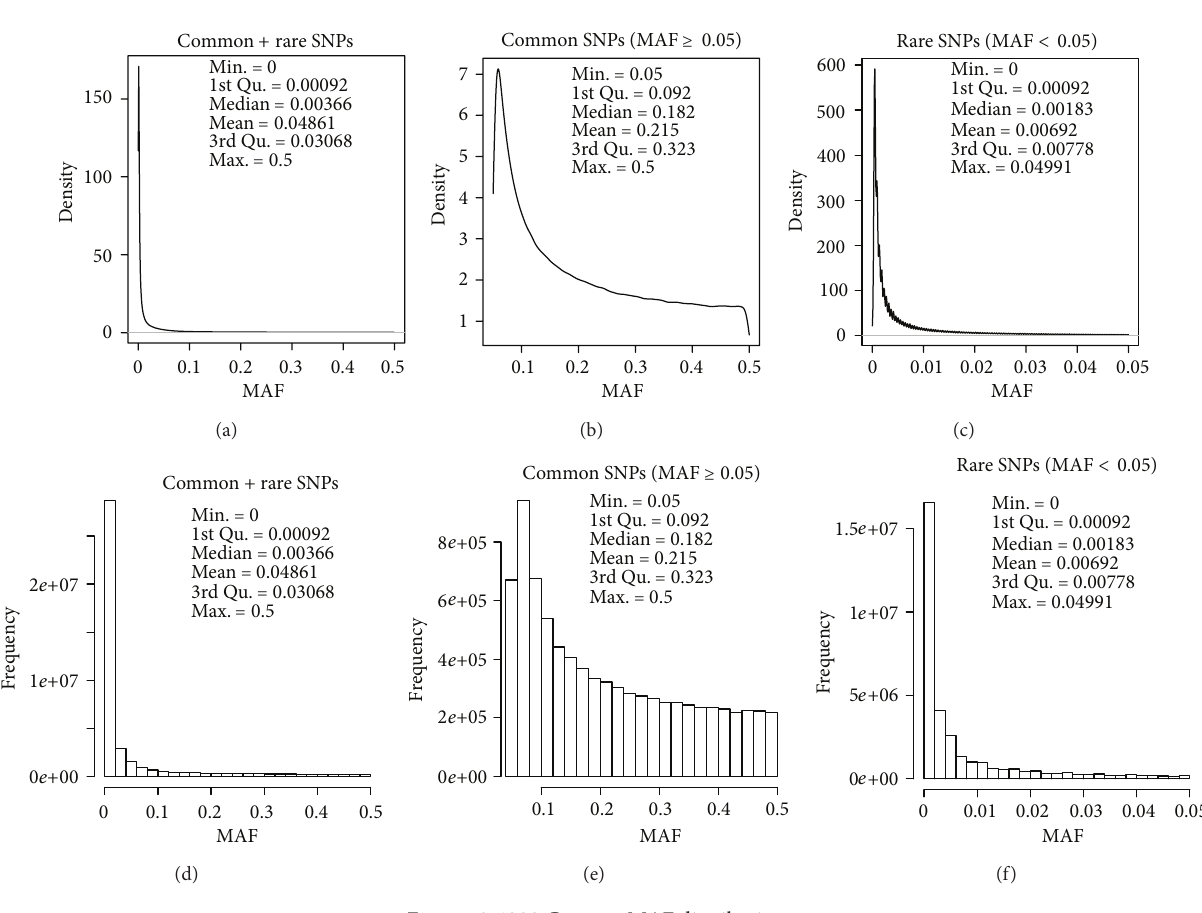
Figure 3: 1000 Genome MAF distributions. Table 2: Statistics for doing 10,000 simulations at different MAFs.